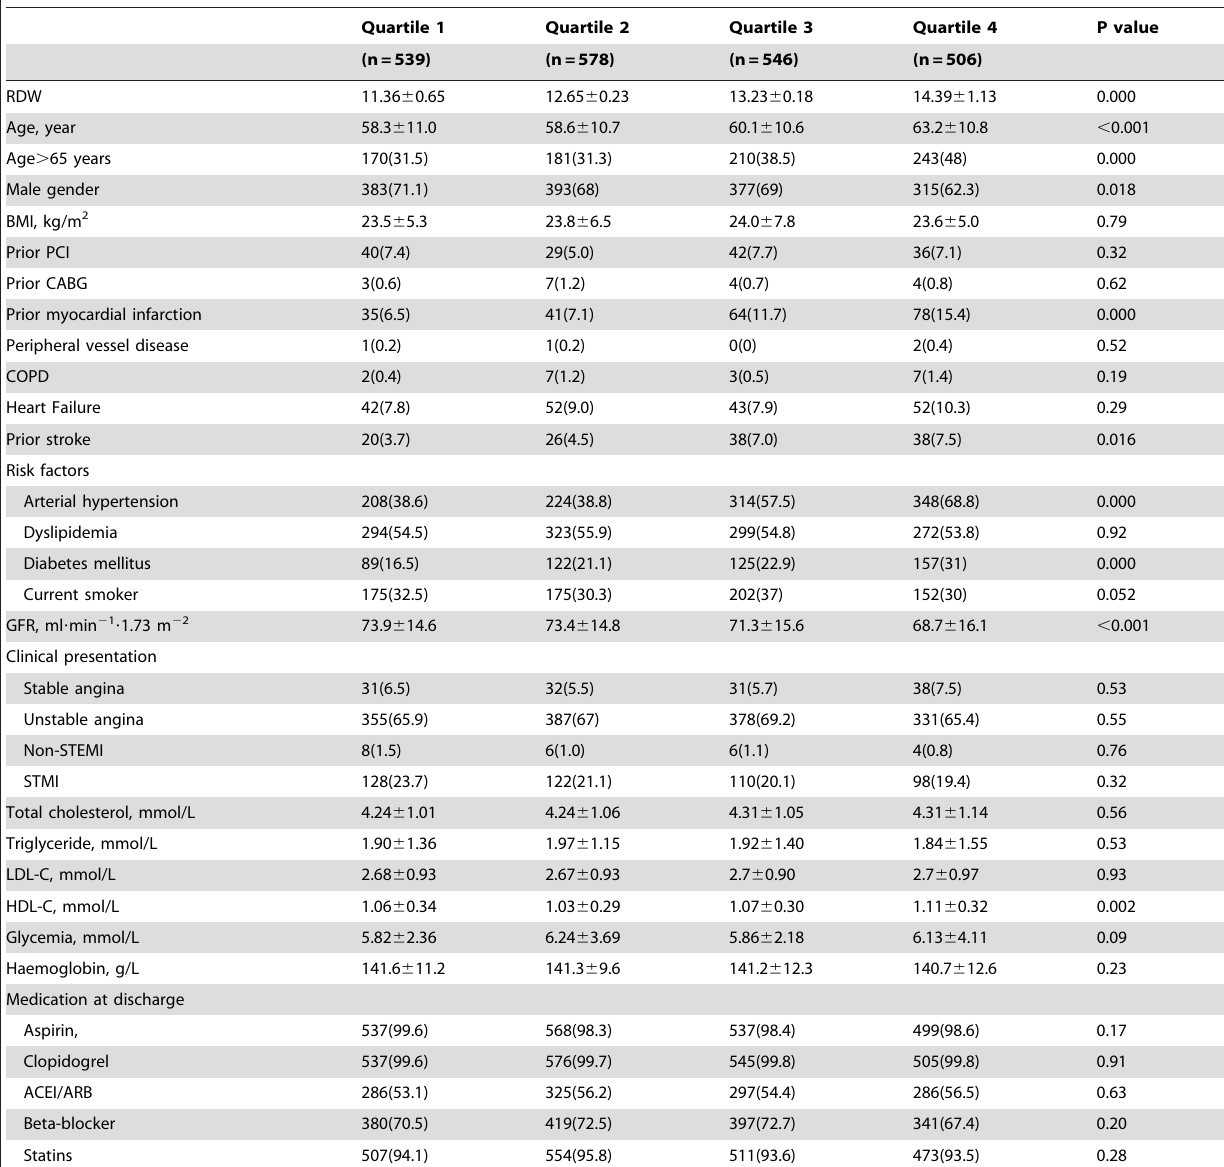
Table 1. Baseline characteristics of participants by Quartile of